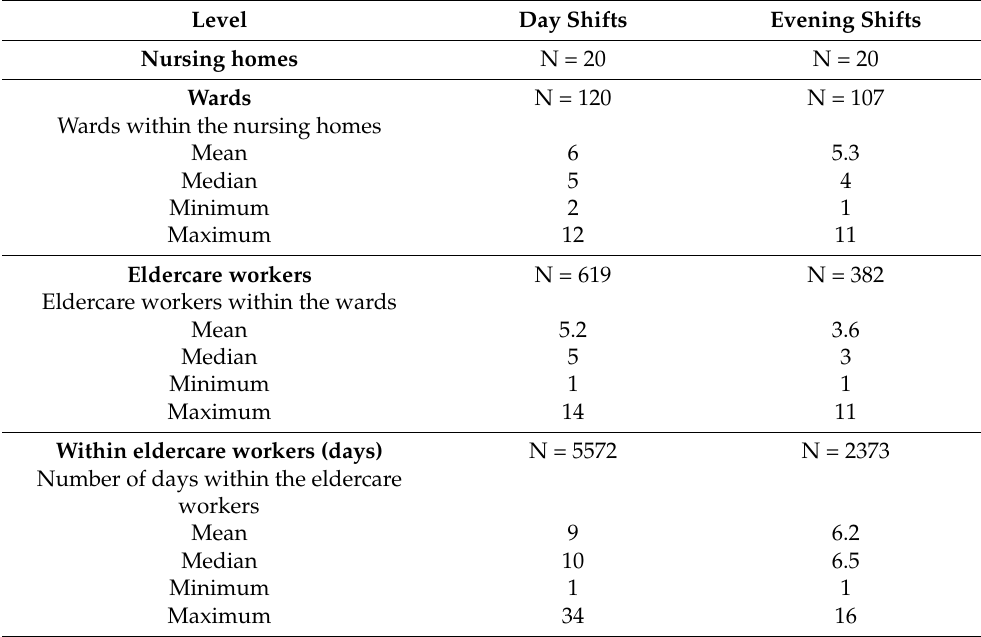
Table 1. Descriptive of the hierarchical structure and the clusters within the four levels of the dataset. N = Total population. Level Day Shifts Evening